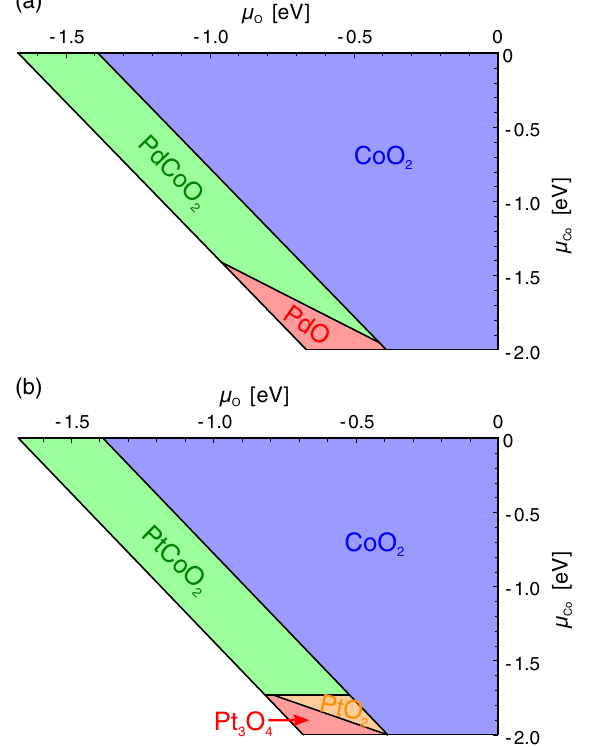
FIG. 16. T ¼ 0 stability diagram for (a) PdCoO 2 and (b) PtCoO 2 with respect to O and Co chemical potentials. Green region corresponds to chemical potentials where the delafossites are